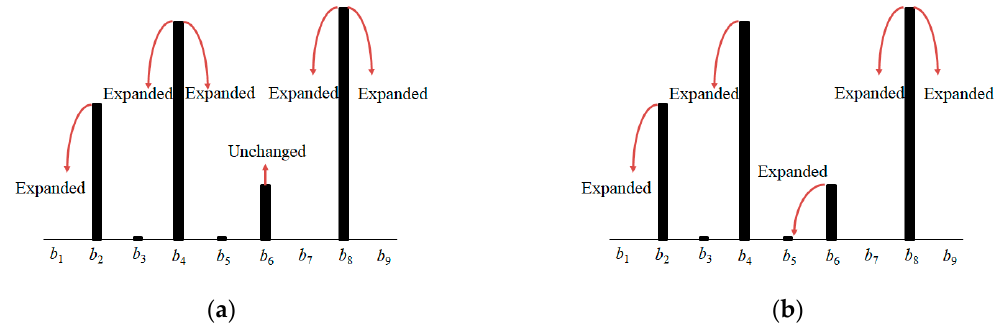
Figure 6. Two Expanding schemes. ( a ) Expanding scheme: E1. ( b ) Expanding scheme: E2.